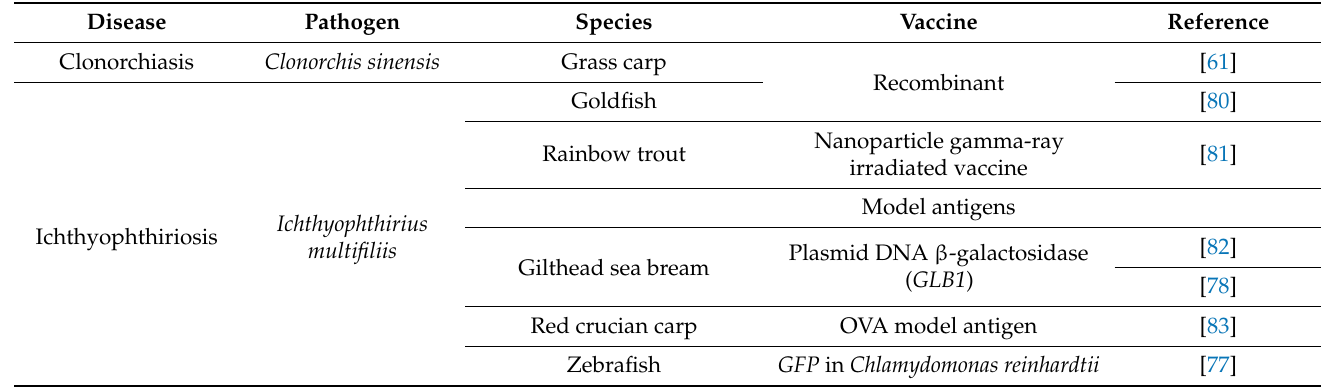
Table 3. Overview of recent oral vaccination trials against a parasitic disease and experiments using model